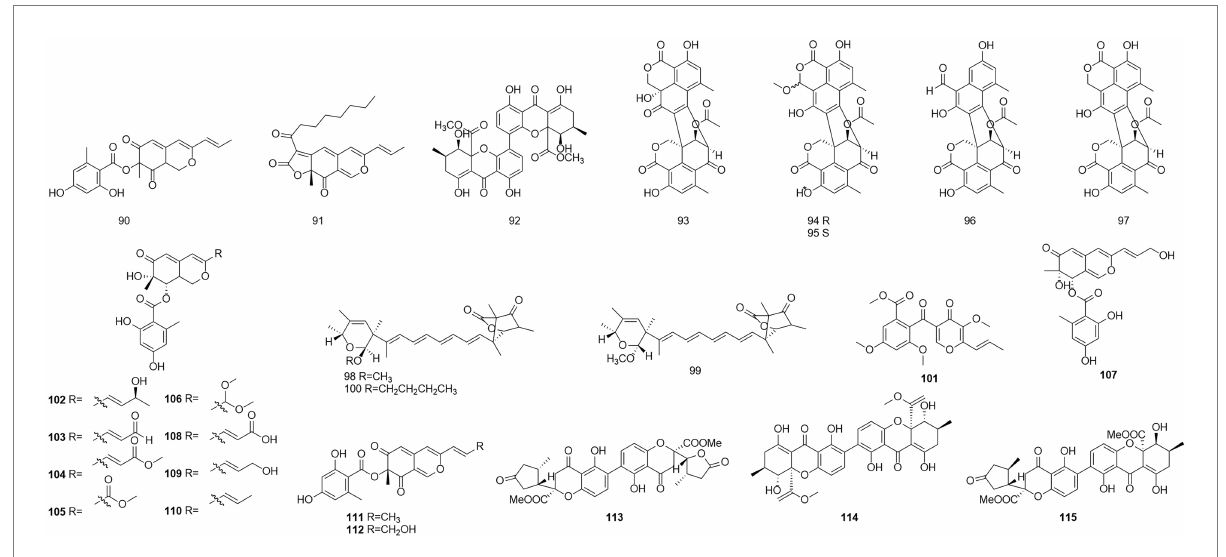
FIGURE 6 Chemical structures of compounds 90–115 .